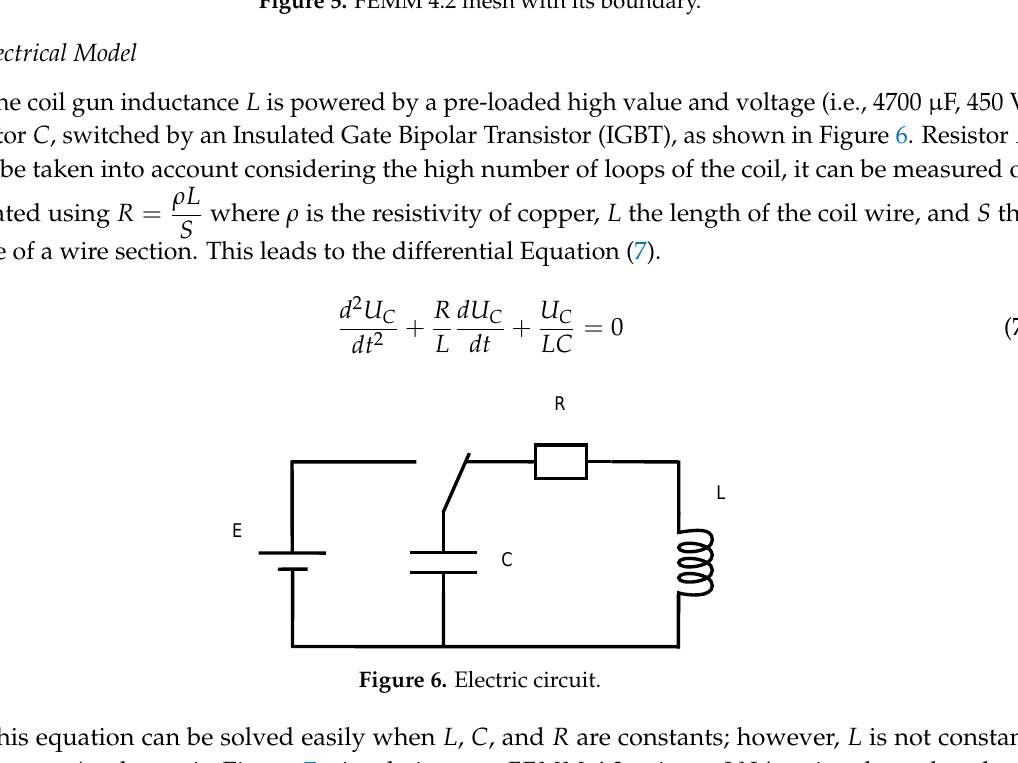
Figure 5. FEMM 4.2 mesh with its boundary.